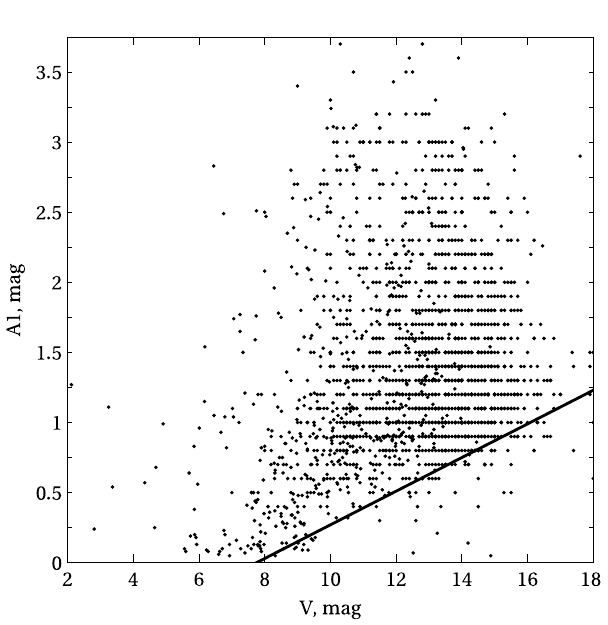
Fig. 3. Depth of primary minimum vs. brightness of Algols catalogued in CEV. An “avoidance triangle” in the lower right corner is discussed in the text.